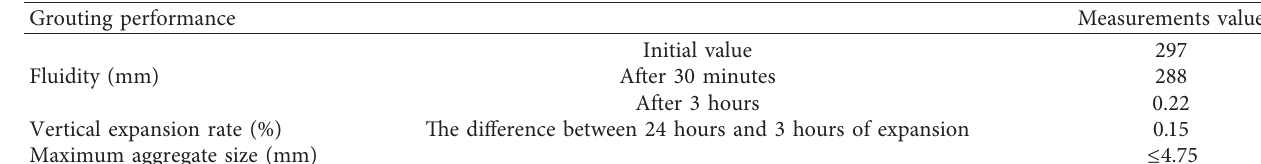
Table 4: Grouting material performance